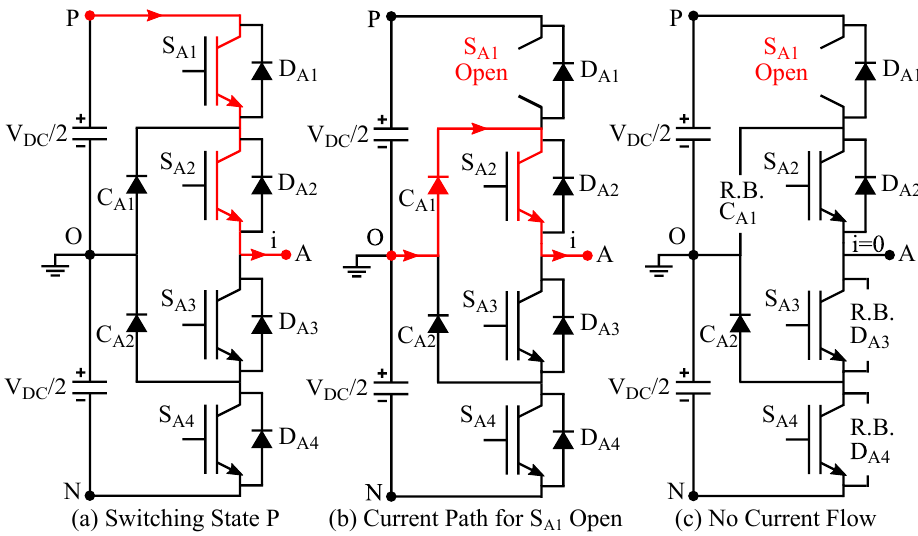
Figure 4. Circuit diagram for S A 1 open switch